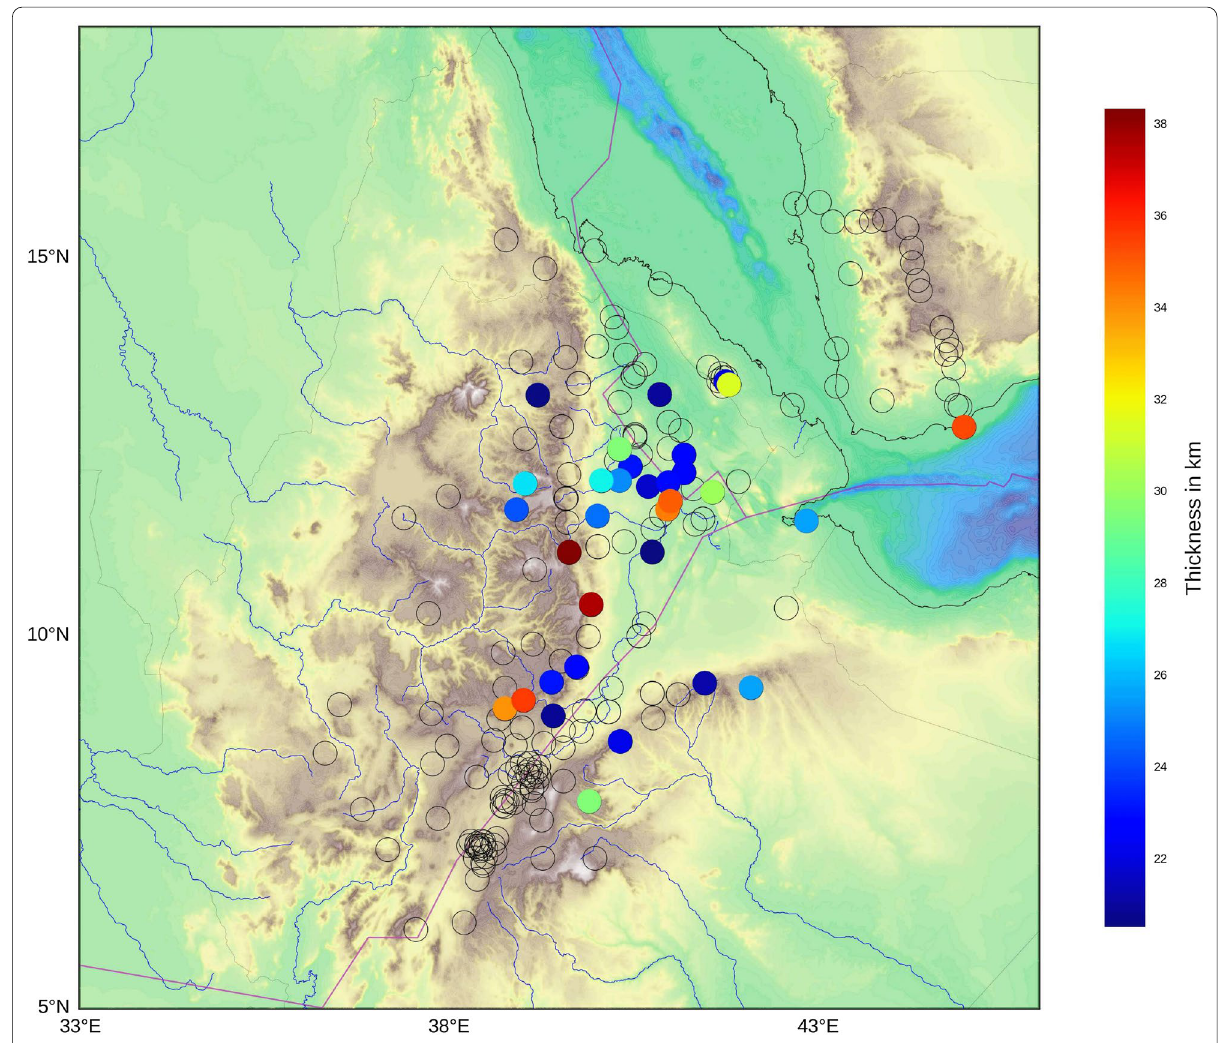
Fig. 10 Moho depths computed by the H – κ stacking method (Zhu and Kanamori 2000) near the Afar triple